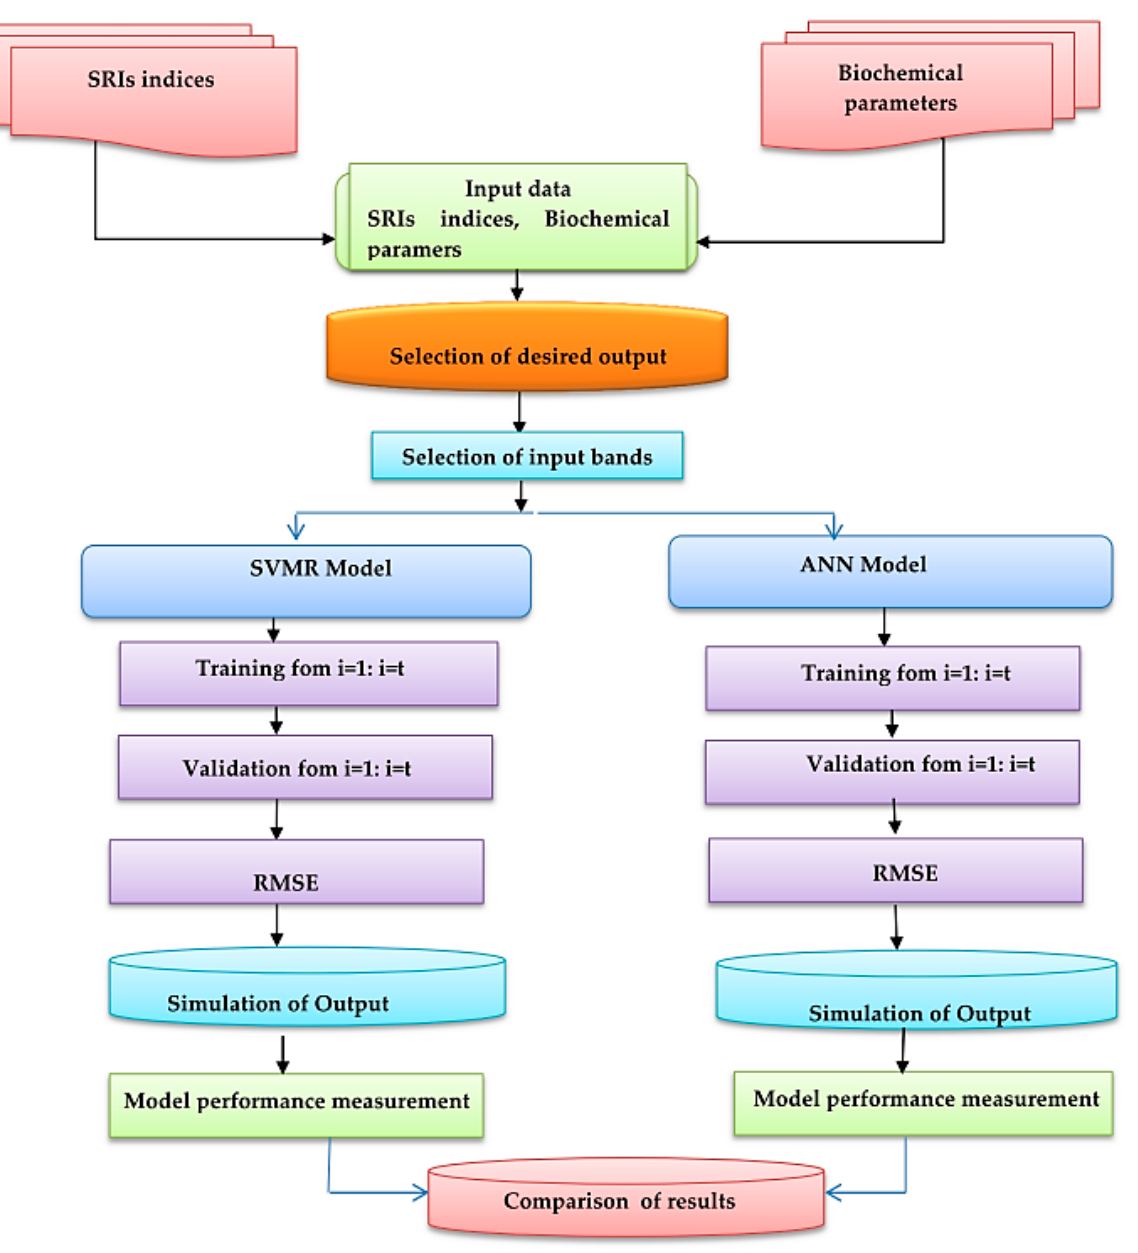
Figure 2. Schematic flowchart of the process of ANN and SVMR used to assess Chl a, Chl b, respiration rate, TSS, and firmness of banana fruits in this